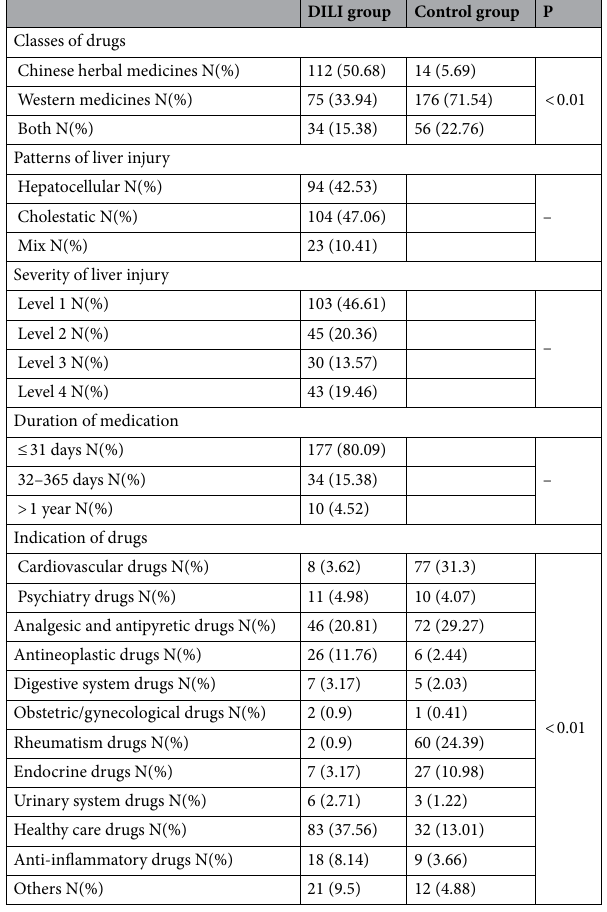
Table 3. Different classes of DILI and control group. DILI drug induced liver injury. A record of all drugs prescribed for each DILI cases is